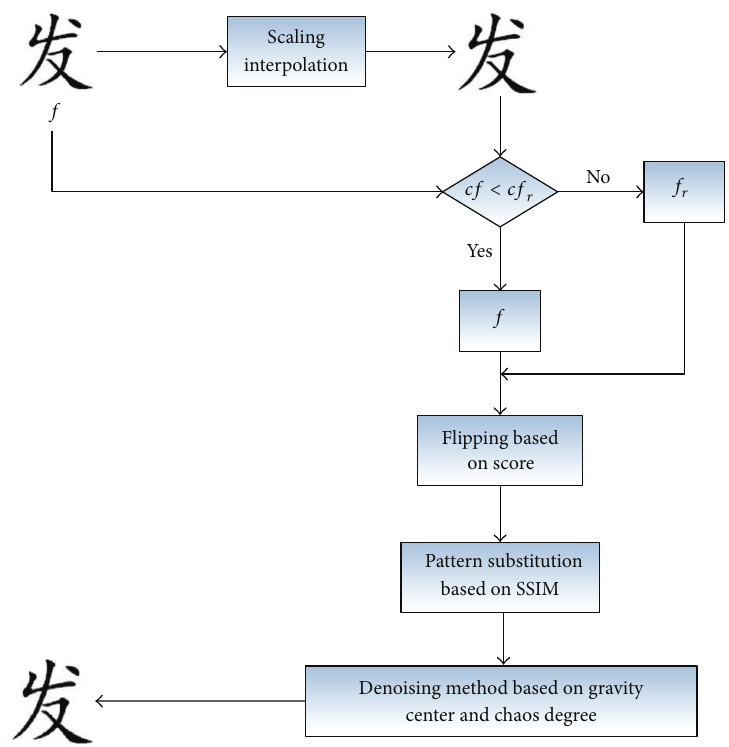
Figure 1: Algorithm flow chart: 𝑓 represents the original image, 𝑓 𝑟 represents the binary font image after being processed using scaling interpolation method, and 𝑐𝑓 , 𝑐𝑓 𝑟 represent the numbers of pixels that need to be flipped, respectively. 𝐹 is the resulting binary font image.